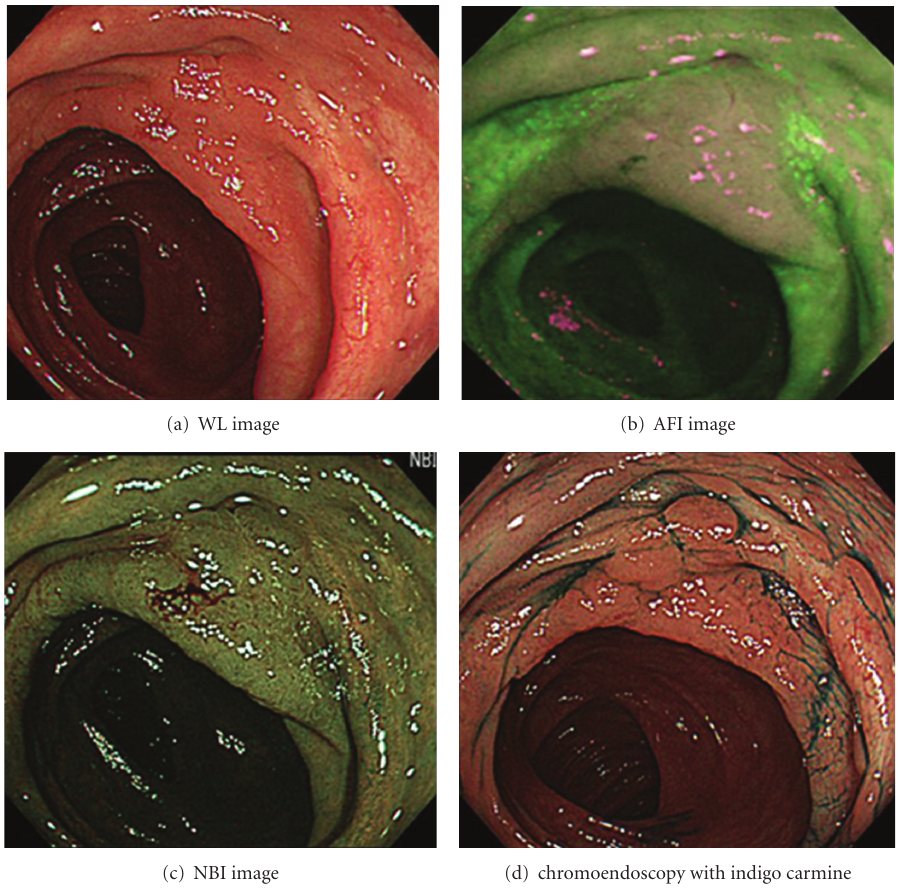
Figure 3: LST-NG lesions categorized as “wellvisualized” using AFI. Location: Transverse colon. Size of the lesion: 45 mm. Macroscopic type: IIa (LST-NG). Pathological findings: well-di ff erentiated adenocarcinoma, low-grade atypia,